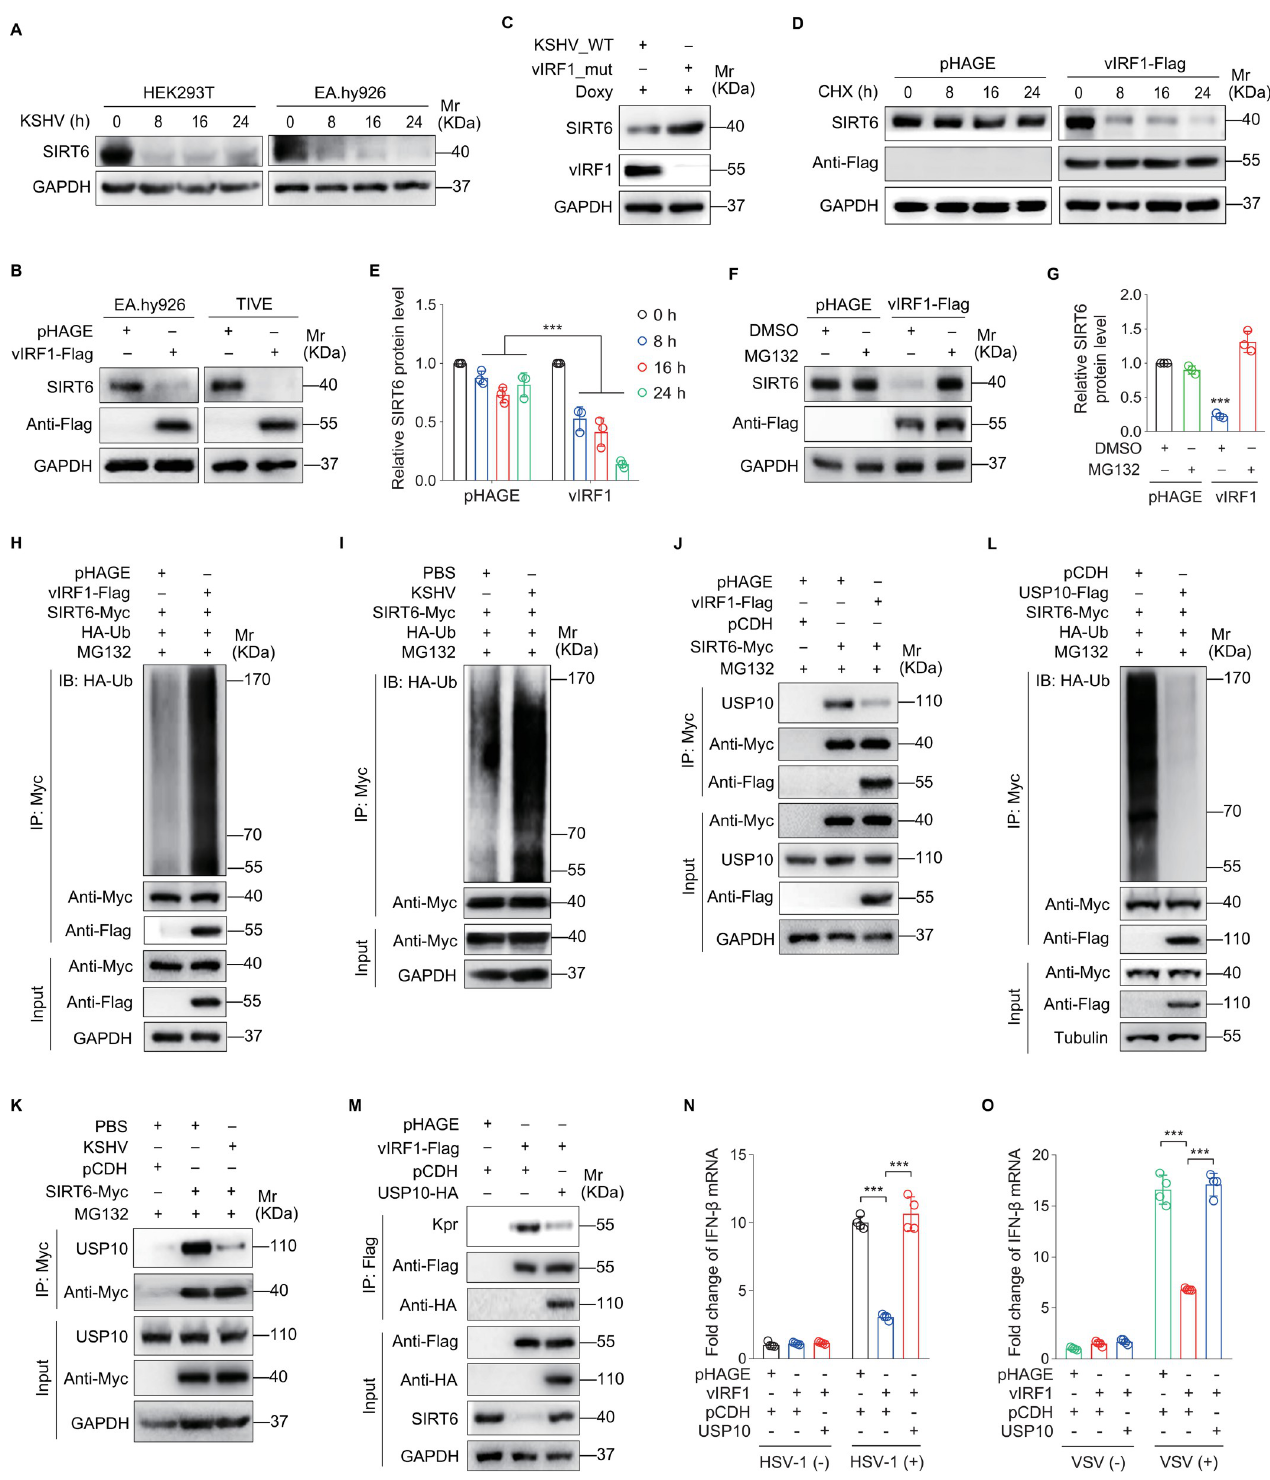
Fig 4. vIRF1 promotes SIRT6 degradation by disrupting the recruitment of its deubiquitinase USP10. (A). The protein expression levels of SIRT6 in HEK293T and EA.hy926 cells infected with KSHV for 0, 8, 16, 24 h were examined by Western blot. (B). The protein expression levels of SIRT6 in EA.hy926 and TIVE cells transduced by lentiviral vIRF1 ( vIRF1-Flag ) or its control ( pHAGE ) were analyzed by Western blot. (C). The protein expression levels of SIRT6 in iSLK-RGB ( KSHV_WT ) and K9_mutant iSLK-RGB ( vIRF1_mut ) cells were analyzed by Western blot after doxycycline ( Doxy ) treatment for 48 h. (D).